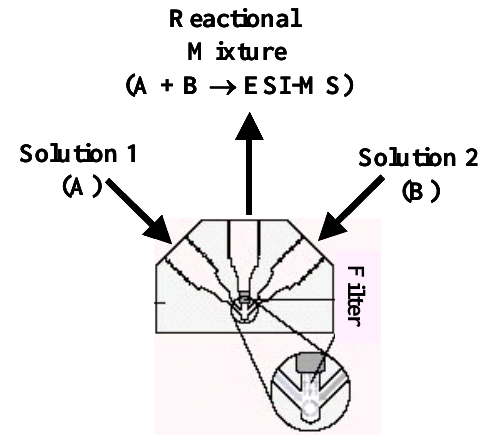
Figure 11. The microreactor allows the effective mixing of the reactants in solution and is coupled directly to the electrospray ion